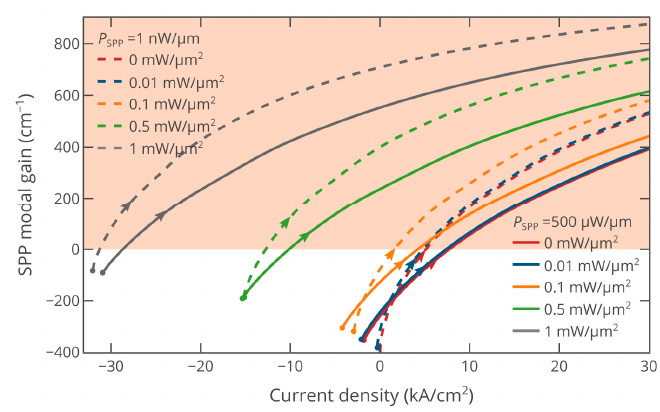
Figure 3. SPP modal gain in the hybridly pumped active plasmonic waveguide as a function of the current density at different levels of optical pumping for the SPP powers of 500 μW/μm (solid lines) and 1 nW/μm (dashed lines). The dots on the curves correspond to V = 0 V, while the arrows show the direction of the bias voltage increase.